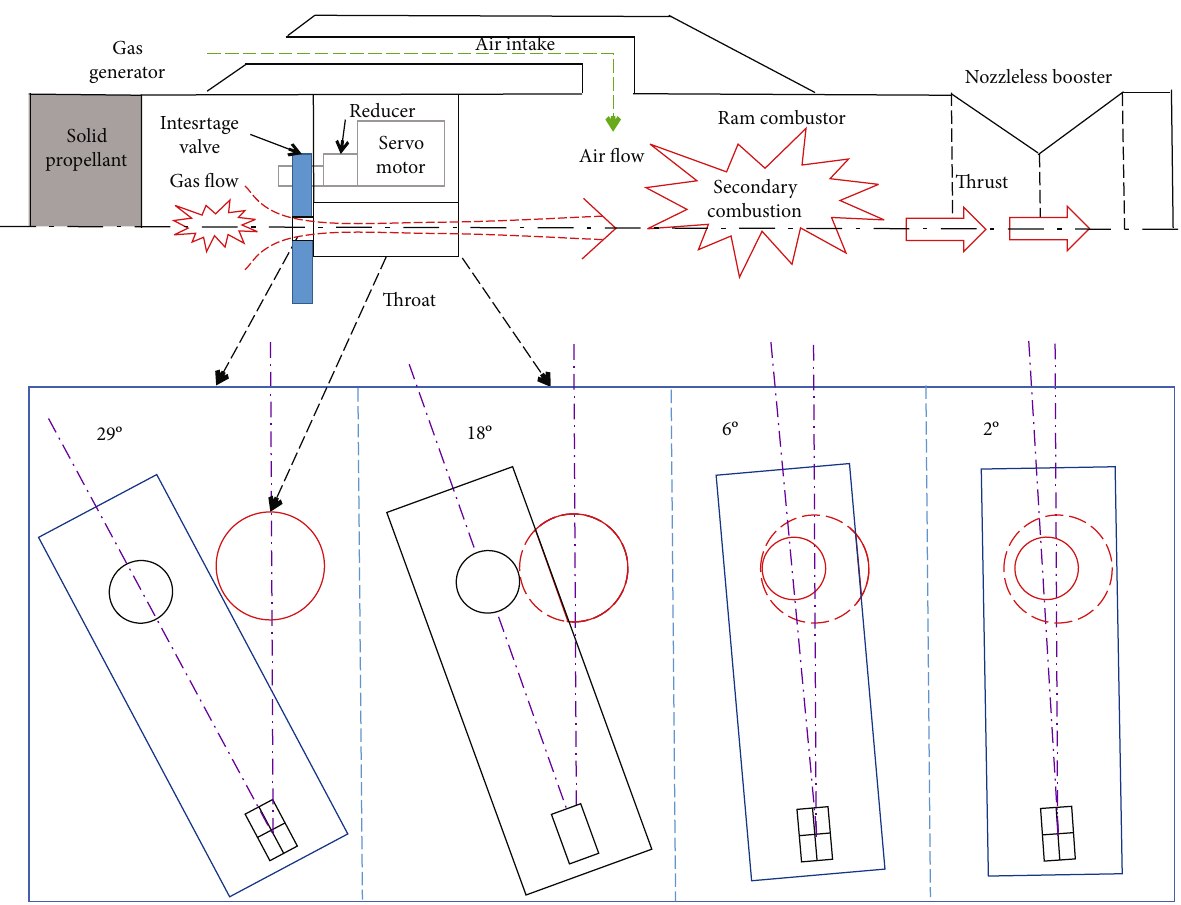
Figure 2: Schematic diagram of valve angle and throat